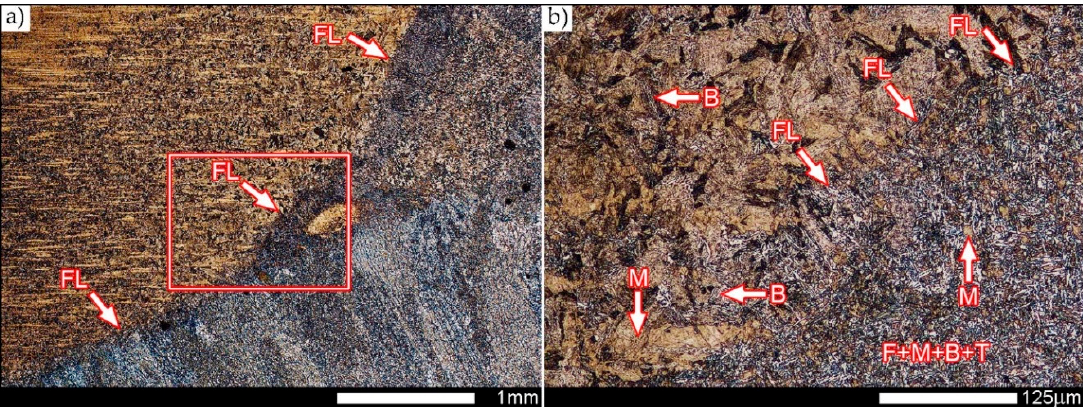
Figure 16. Microstructure of Hardox Extreme welded joint after welding: ( a ) in the area marked FZ1 in Figure 5; ( b ) an enlarged image marked with frame in Figure 16a. Very clearly outlined fusion line (FL) with strongly diversified microstructure. Visible islands of hardening martensite (M) and bainite (B), troostite areas (T) and acicular ferrite (F). Light microscopy, etched with 2% HNO 3 .